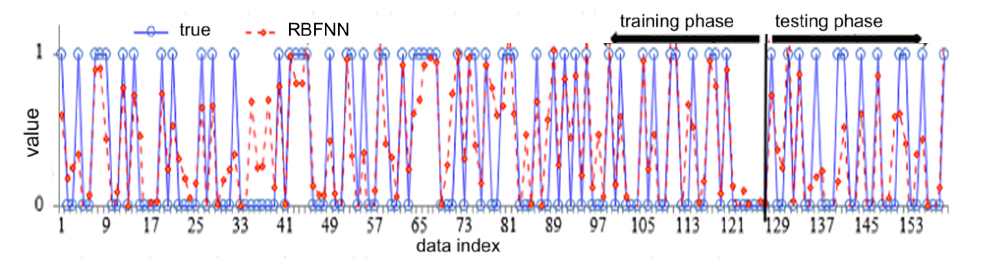
Figure 18. The true data points—blue—versus the training and testing outcomes—red points and lines—of RBFNN; see abbreviations in Nomenclature.